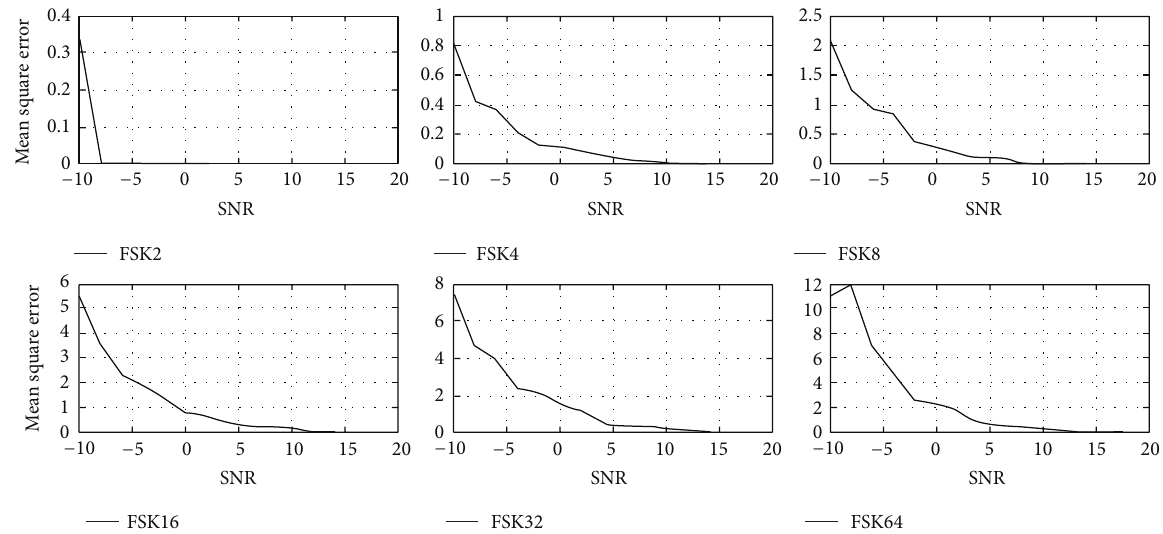
Figure 8: Training of Gabor filter parameters and weights for modulation classification in case of FSK modulation 2–64 at different SNRs and fixed number of iterations.